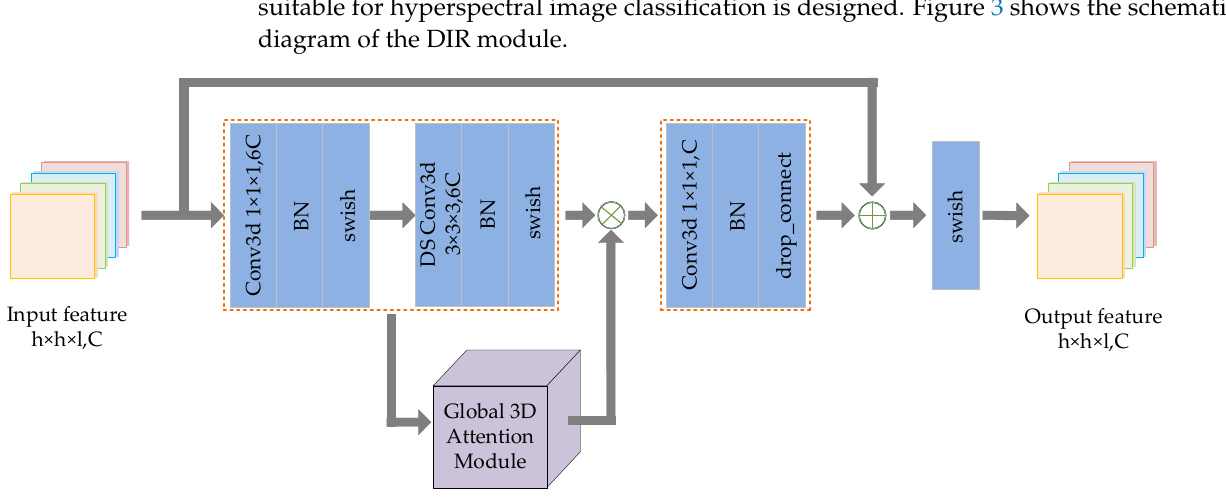
Figure 3. The schematic diagram of DIR module.